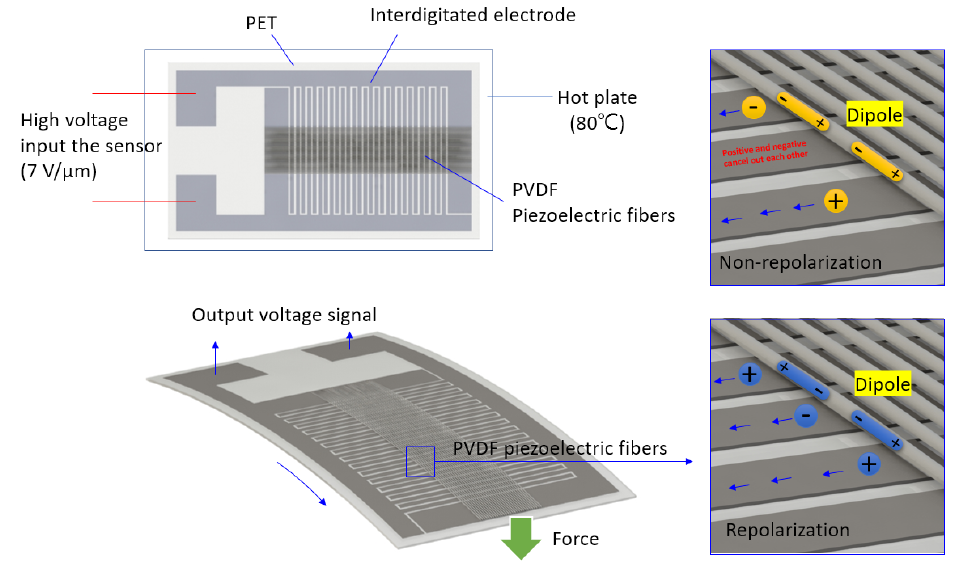
Figure 9. Illustration of PVDF piezoelectric fibers (area: 28 × 10 mm 2 , about 3000 fibers) that were placed on various flexible (PET) interdigitated electrodes.